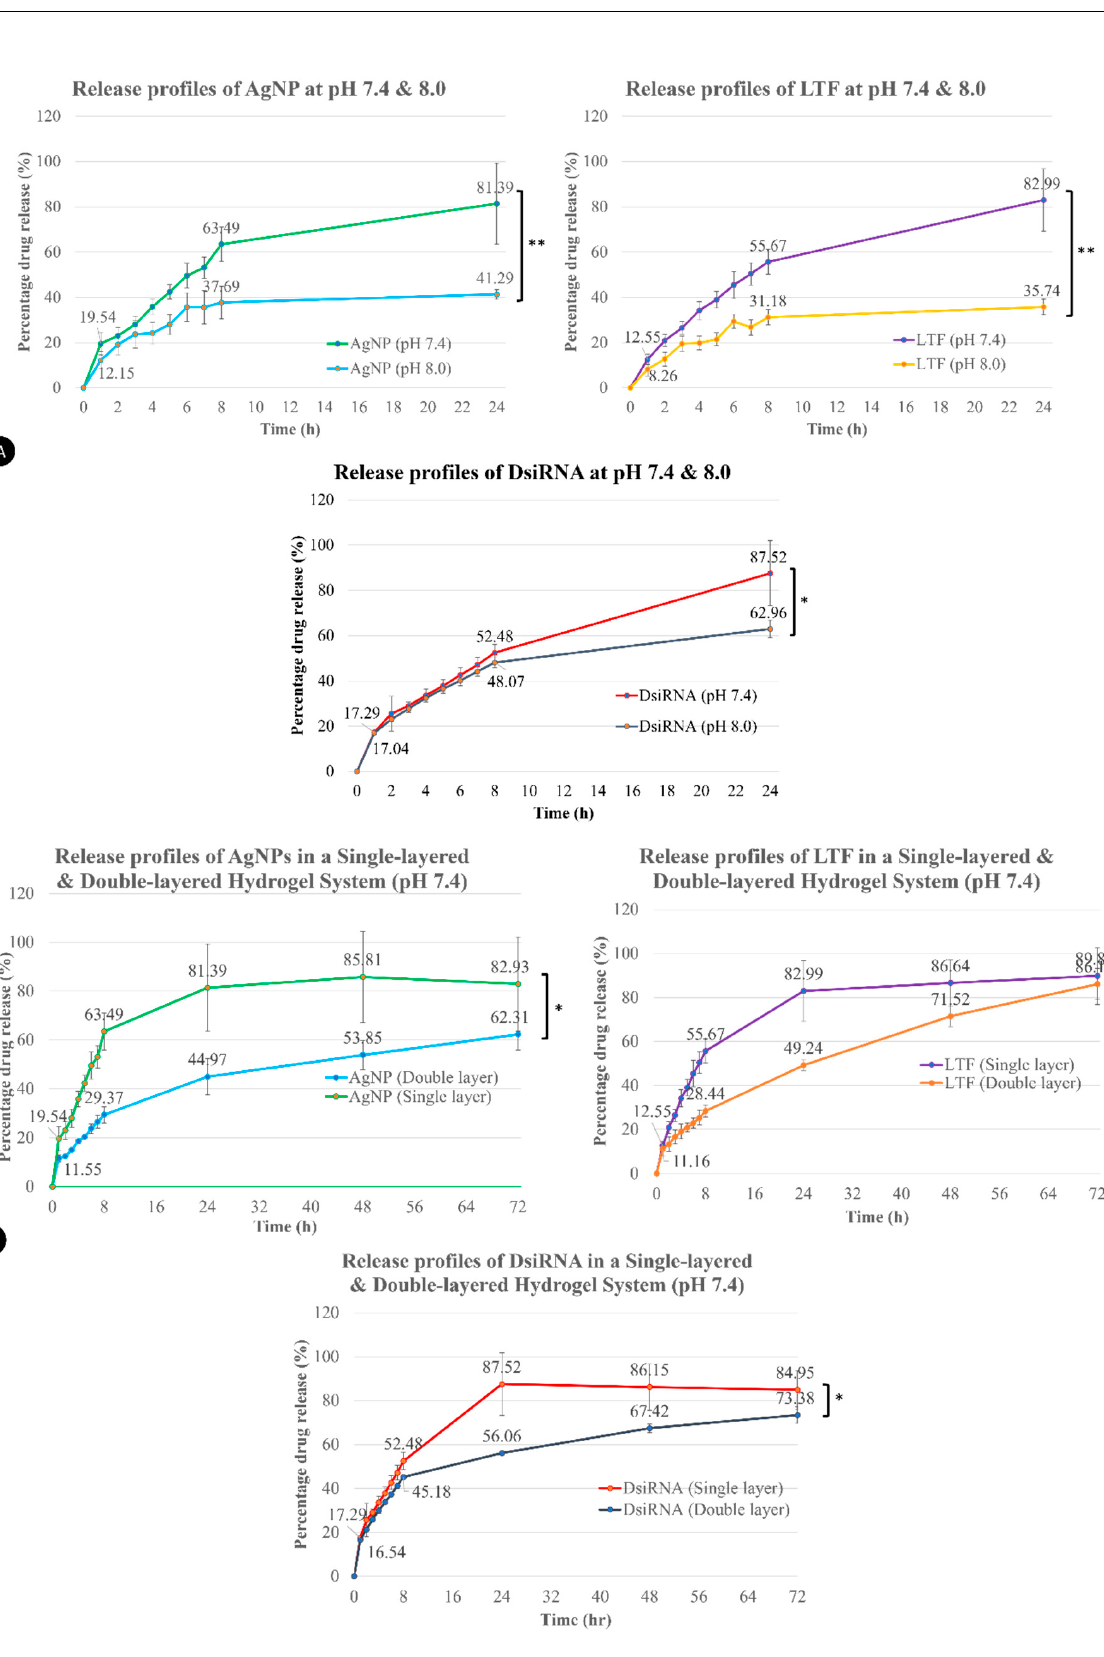
Figure 7. In vitro drug release of AgNPs, AgLTF, and DsiRNA ( A ) at pH 7.4 and 8.0 ( B ) from the SL and DL gelatin hydrogels, n = 6. * statistically significant difference ( p < 0.05); ** statistically significant difference ( p < 0.01).